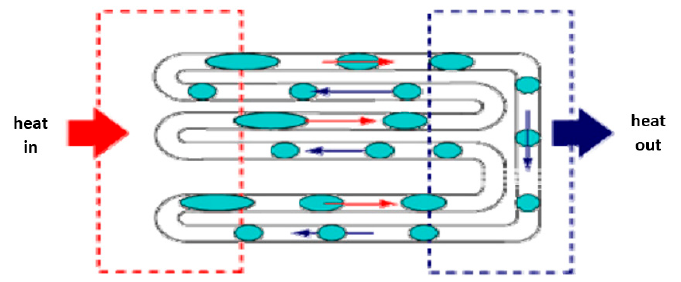
Figure 1. Pulsating heat pipe [5].